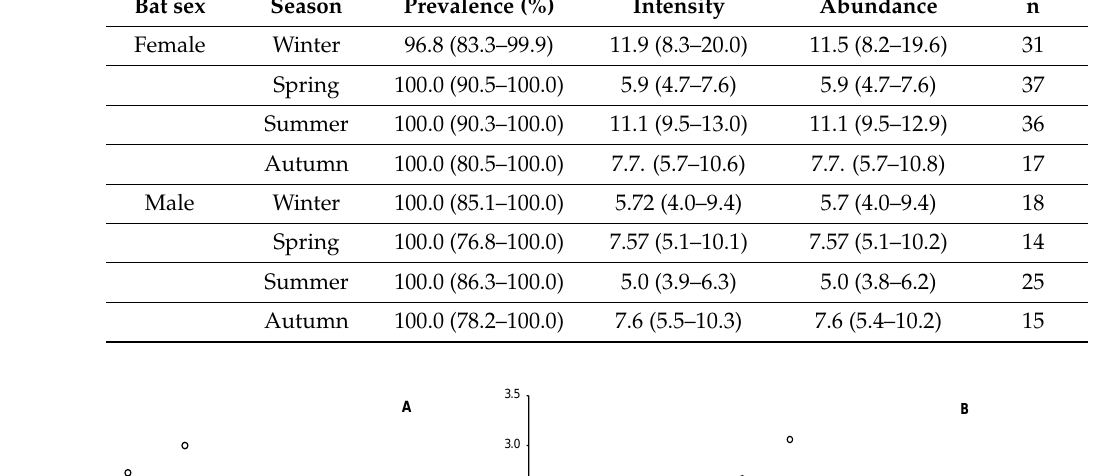
correlated with the BKA in females (R = −0 .12, p = 0.23, n = 108; Figure 7A) but the corre- lation was significant for males (r = −0 .24, p = 0.04, n = 65; Figure 7B). Table 2. Prevalence, intensity, and abundance of ectoparasites in female and male fish-eating myotis ( Myotis vivesi ) during four seasons in Partida Norte Island, Mexico. Values are mean (95% confidence interval) and were obtained with the program Quantitative Parasitology–QPweb 1.0.13 (Reiczigel et al. 2019). We used the Clopper–Pearson method for the prevalence confidence interval and the bias-corrected and accelerated bootstrap method, with 2000 replications for intensity and abundance confidence intervals.